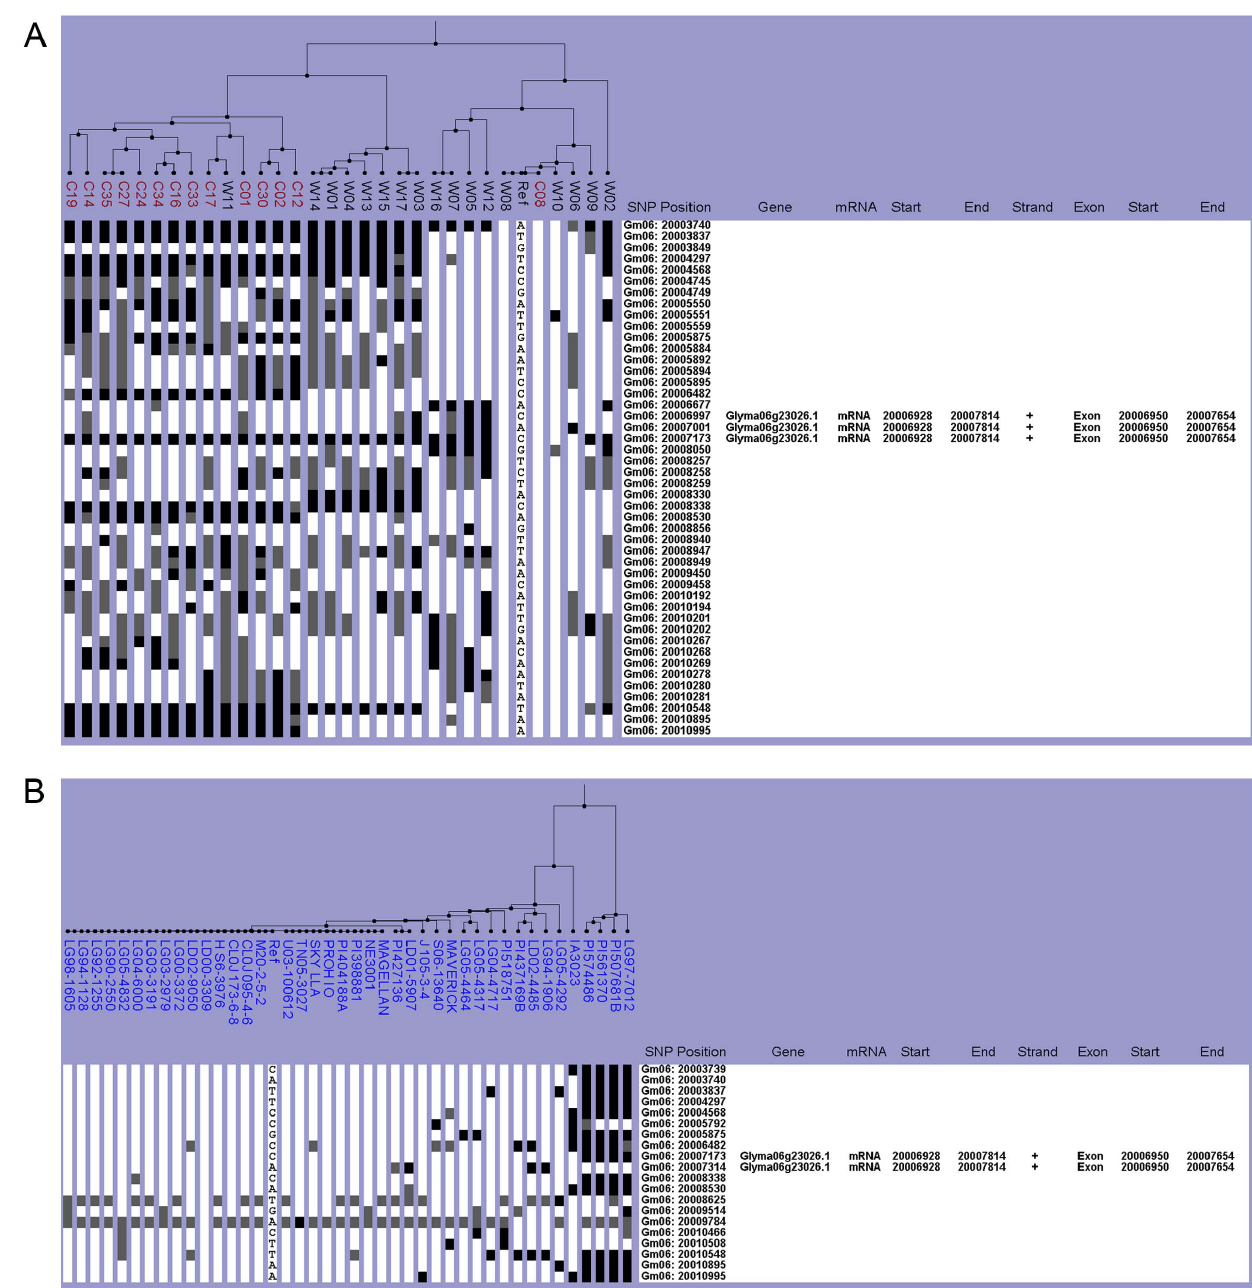
Figure 1. Haplotype analysis of the E1 gene region. The SNPViz clustering pictorial displayed the SNPs in a 7.8-kb region on chromosome six, which included Glyma06g23026. UPGMA grouped samples by calculating their sequence identity to the reference, Williams 82. Each soybean line was represented by a column with nucleotides only shown for the reference. All base positions that are identical to the reference are white, those that are different are black, and positions with no data or missing data are gray. Since an annotation file was included in this analysis, the gene locations, DNA strand, and exon start and end site are shown to the right of SNP position. Nucleotide polymorphisms were examined in A) the wild (black) and cultivated (red) lines from the Chinese collection and B) the NAM parents